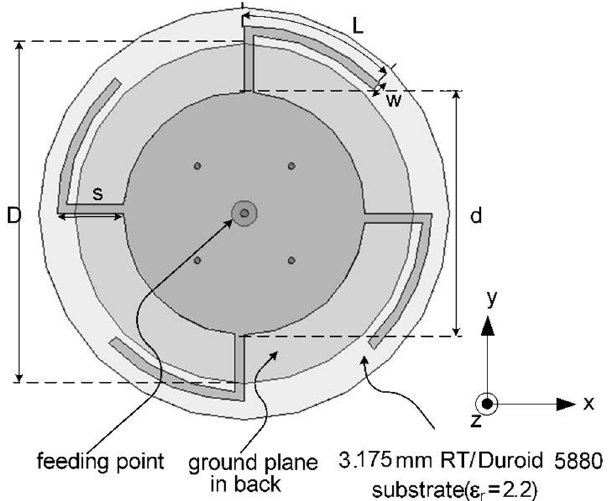
Fig. 8. Structure of the omnidirectional CP EZR antenna.